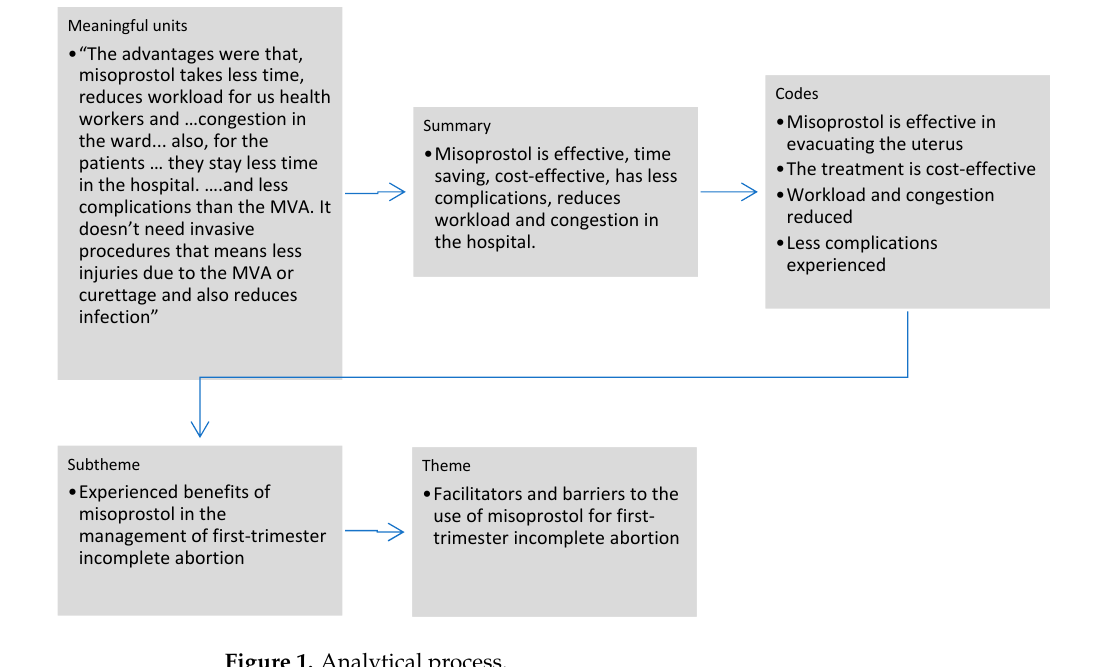
Figure 1. Analytical process.